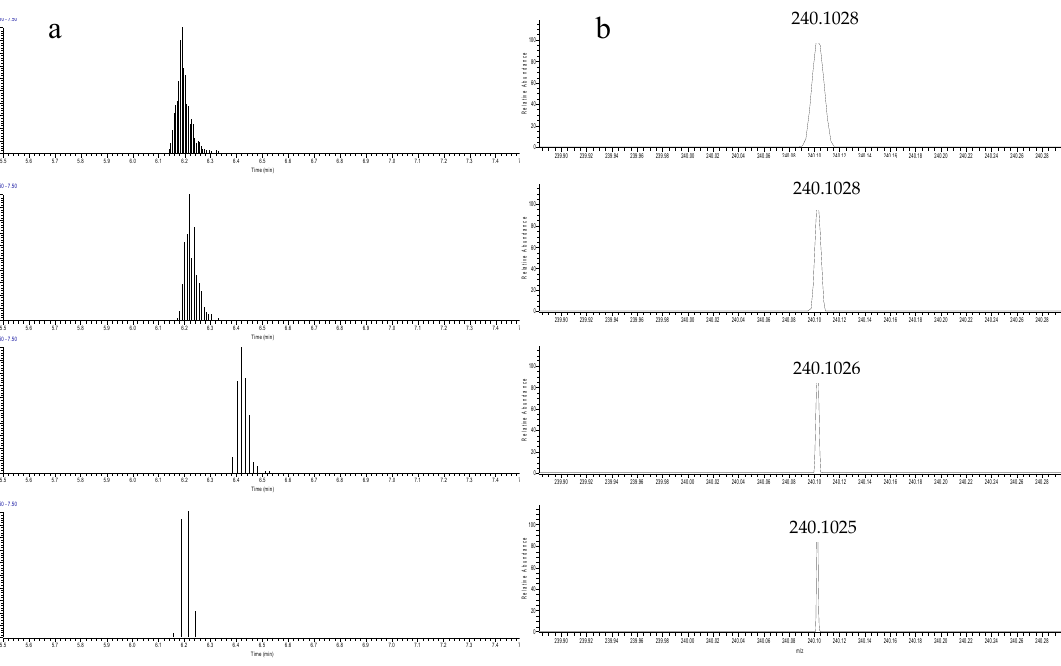
Figure 2. ( a ) Peak chromatogram (presented as data points) and ( b ) mass spectrum of Mefenamic acid (post ‐ spiked sample at concentration 50 ng/L) with the resolution of 15,000 FWHM, 30,000 FWHM, 60,000 FWHM, and 100,000 FWHM (from top to the bottom).